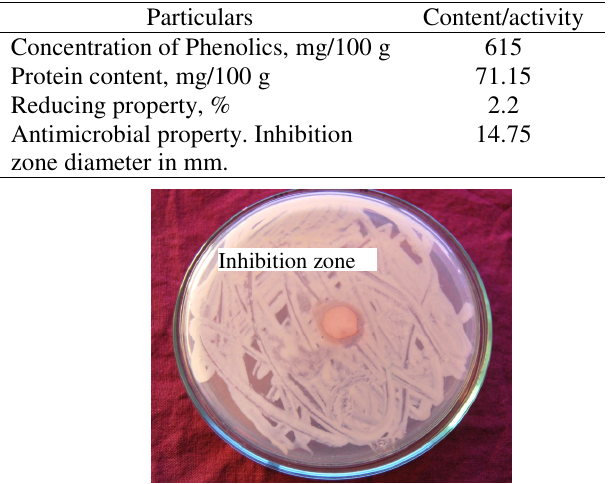
Table 1. The medicinal and nutritional value of Ixora brachiata Roxb.